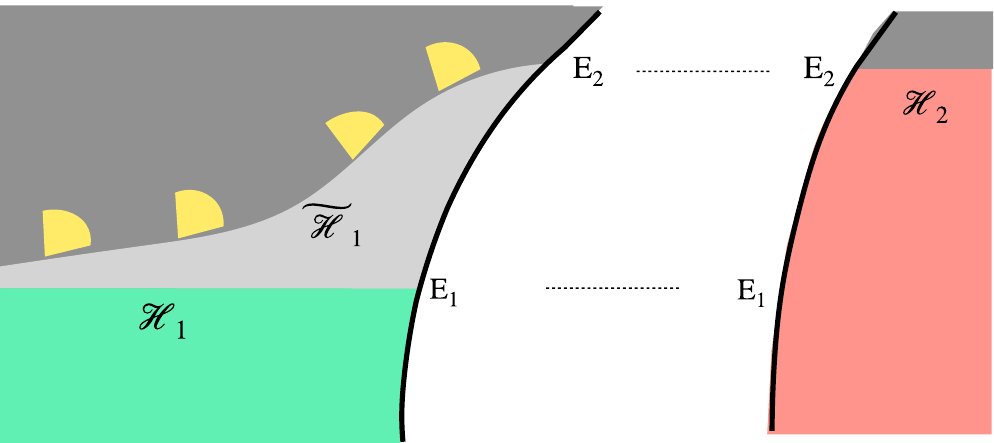
Figure 6 . The event and apparent horizons, e H 1 ∪ H 2 and H 1 ∪ H 2 , as described in the text. The event horizon is connected but it is not Killing. Projections of the local light-cone on a Cauchy slice are shown in yellow. The light grey region behind H is outside the event horizon because signals 1 can escape towards the